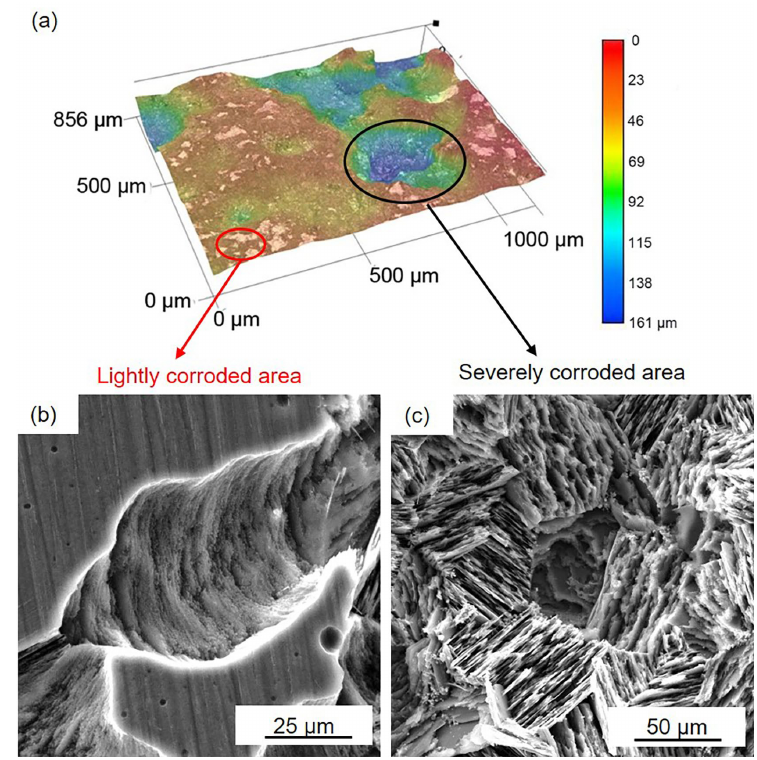
Figure 7. D optical and SEM images of the black areas on the LPSO samples after 24 h immersion: ( a ) 3D optical images, ( b ) SEM images in lightly corroded area, and ( c ) SEM images in the severely corroded area.